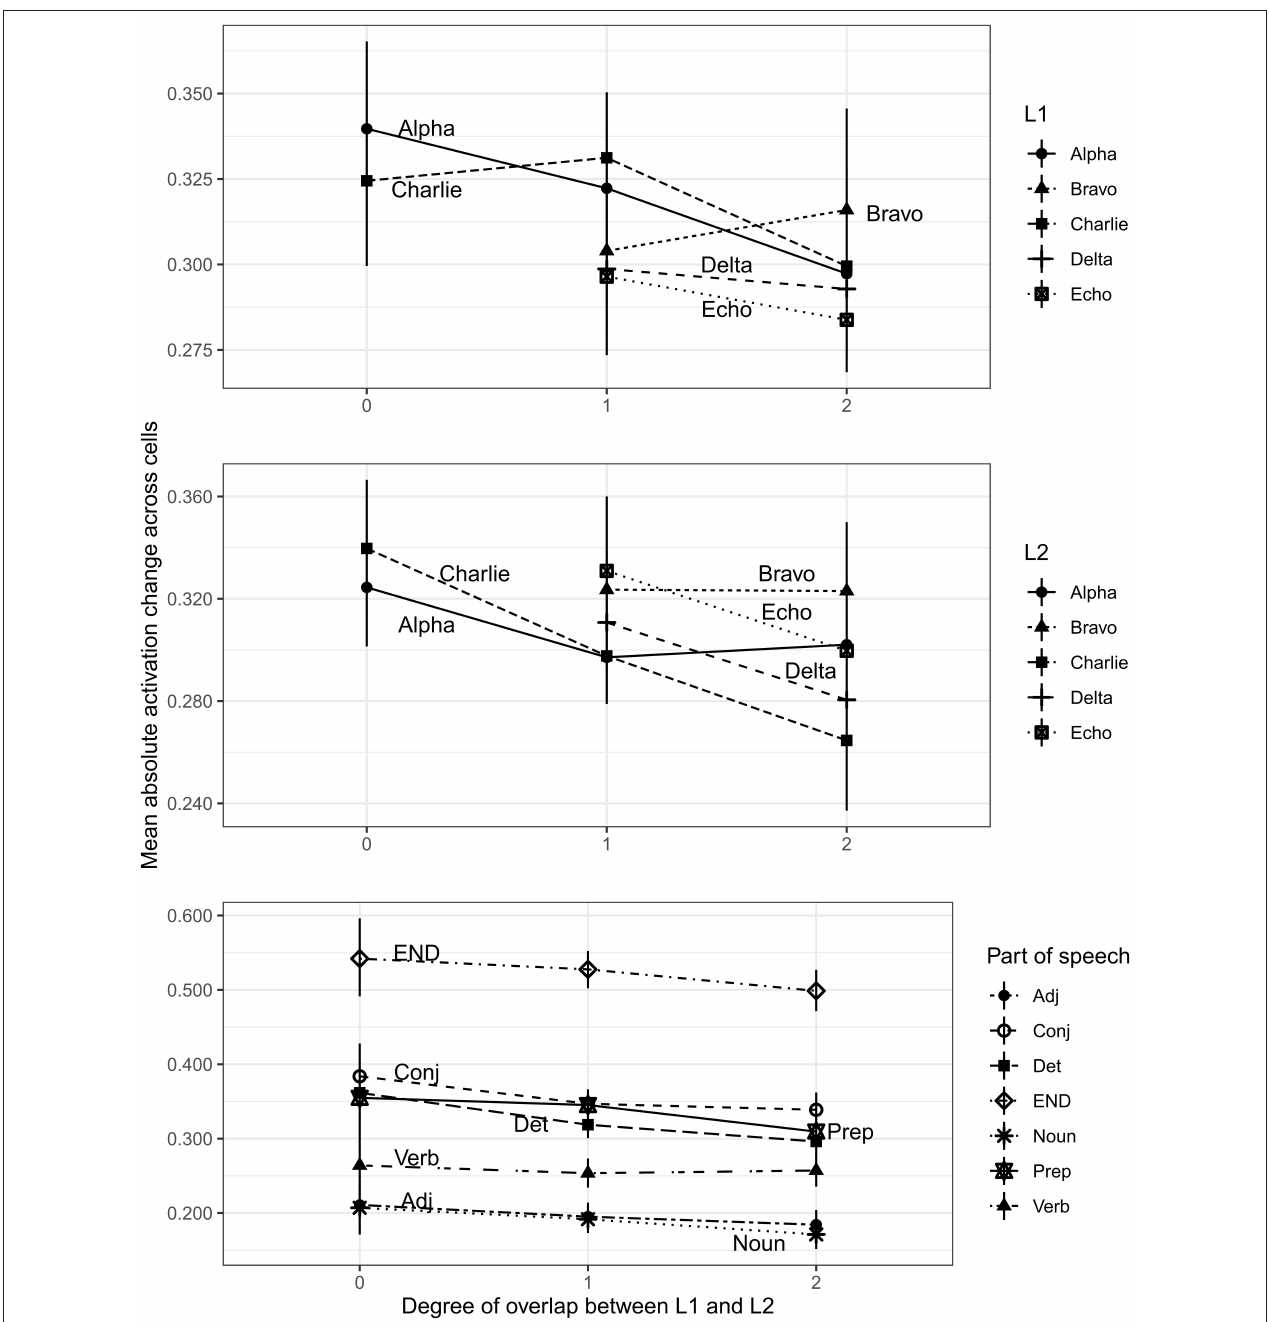
FIGURE 3 | Absolute cell activity change for models learning L2 after L1, averaged across all 100 hidden cells. The top panel shows the activity change grouped by the L1; the middle panel shows the activity change grouped by the L2; and the bottom panel shows the activity change when grouped by part of speech.